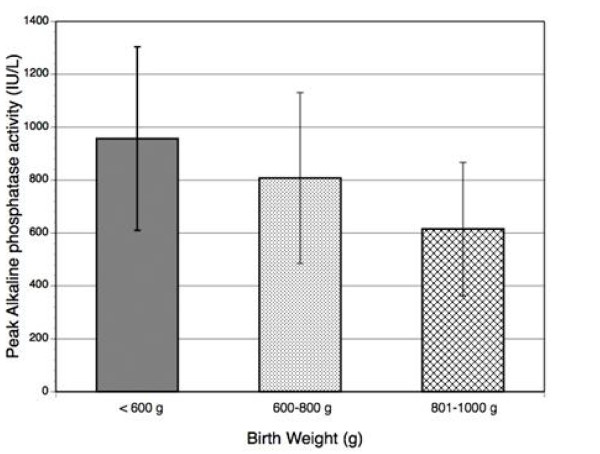
Average peak alkaline phosphatase according to birth weight.